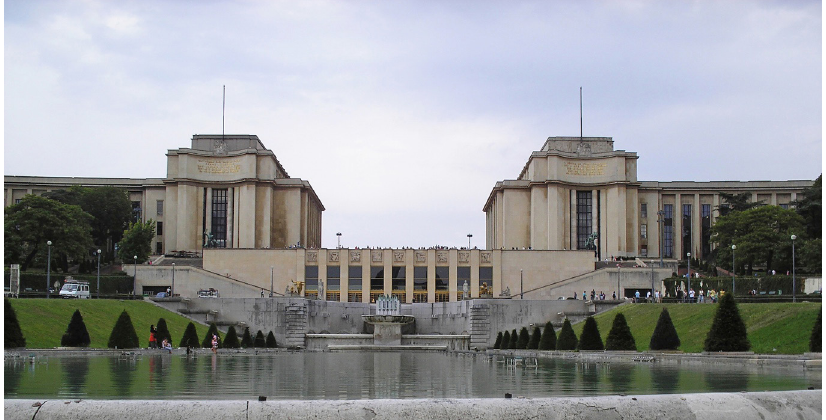
Figure 6. Trocadero, Paris (source: author,